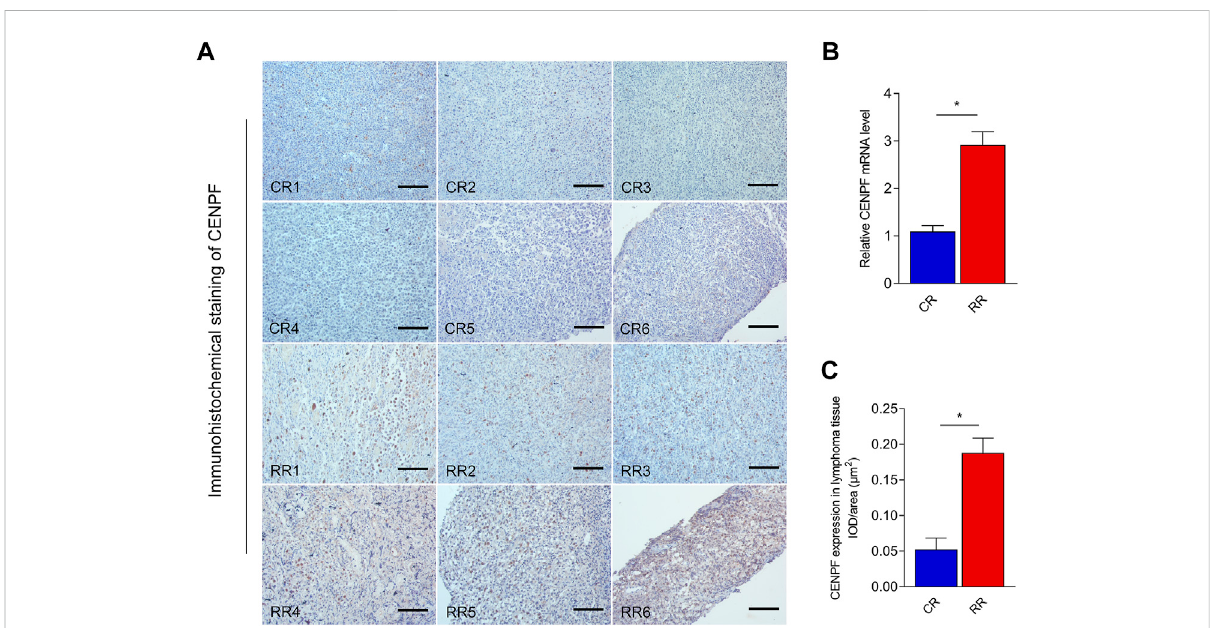
FIGURE 1 Real-time RT ‒ PCR and immunohistochemical staining analysis of CENPF expression in lymphoma (A) . Immunohistochemical staining of CENPF in CR and RR patients with lymphoma. (B) . Real-time RT PCR was performed to reveal the mRNA expression levels of CENPF in complete remission(CR)andrelapsedrefractory(RR)patientswithlymphoma. (C) .QuantitativeanalysisofCENPFexpressedinlymphomatissueindifferentCR and RR patients by using the mean IOD/area ( μ m 2 ). Scale bar is 200 μ